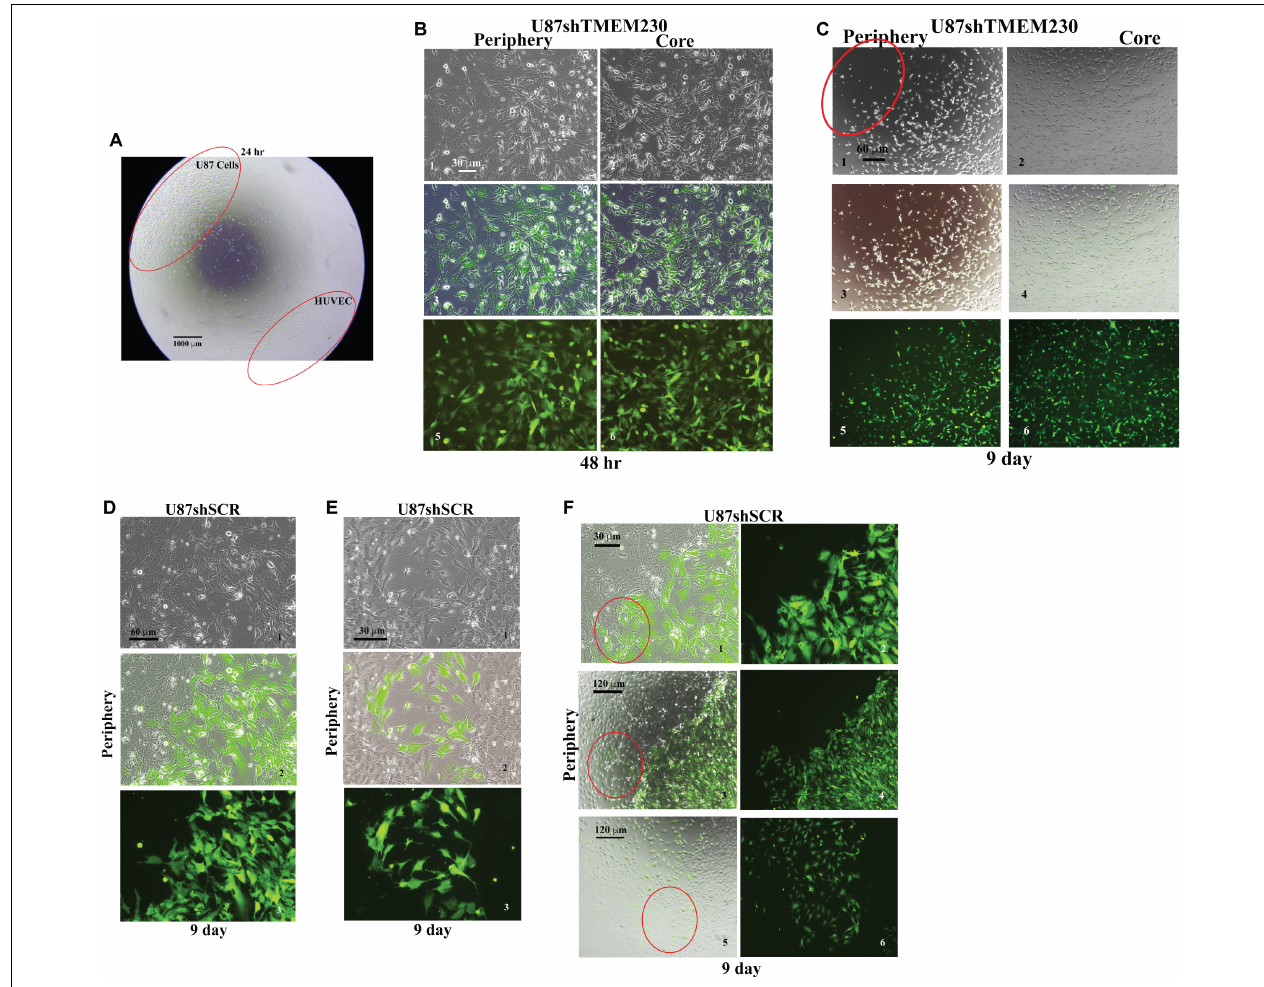
FIGURE 6 | Endogenous TMEM230 promoted U87-MG cell migration, tumor-endothelial cell contact and displacement in co-culture assays. (A) Low magnification shows the co-culture assay set up. (B) Representative images showing the periphery (outgrowth) and core (initial location of cell plating) of U87shTMEM230 cells at 48 h. Downregulation of TMEM230 in U87 cells was associated with cytoplasm of reduced mass, disrupted cytoplasmic invadopodium like extensions, decreased cell anchorage and reduced contacts among initially confluent plated cells. (C) Representative images of U87shTMEM230 cells at periphery and core at 9 days. U87 cells with reduced TMEM230 expression displayed reduced anchorage capacity and motility (see red circle at periphery of initial site of plating of the confluent cells) compared to control cells. (D–F) Displacement of the confluent human umbilical vein endothelial cells by U87 control cells (U87shSCR) expressing endogenous TMEM230 through infiltration into the confluent mass of human umbilical vein endothelial cells (see red circles), a behavior that is associated with the first step of intussusceptive induced blood vessel